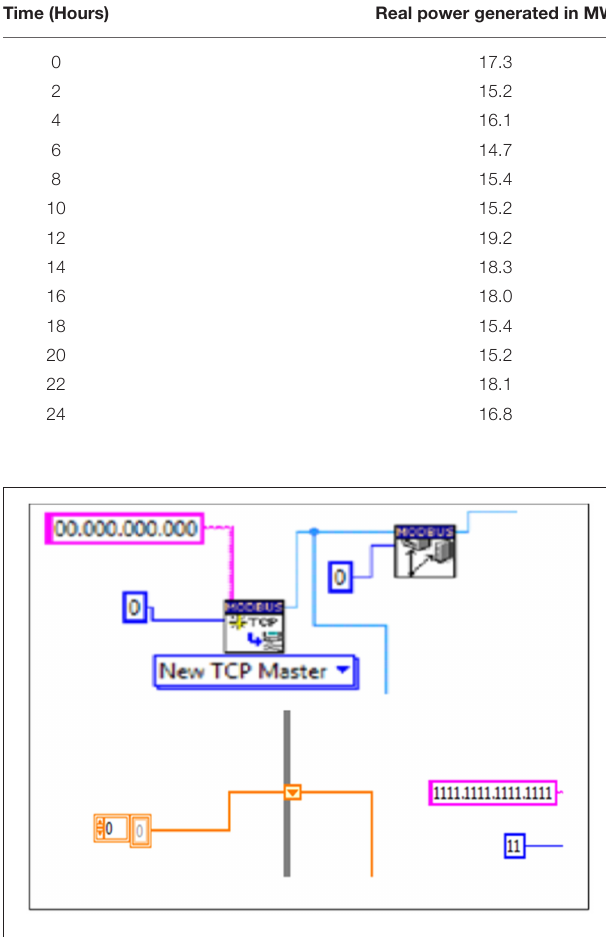
FIGURE 2 | Modbus metering format.